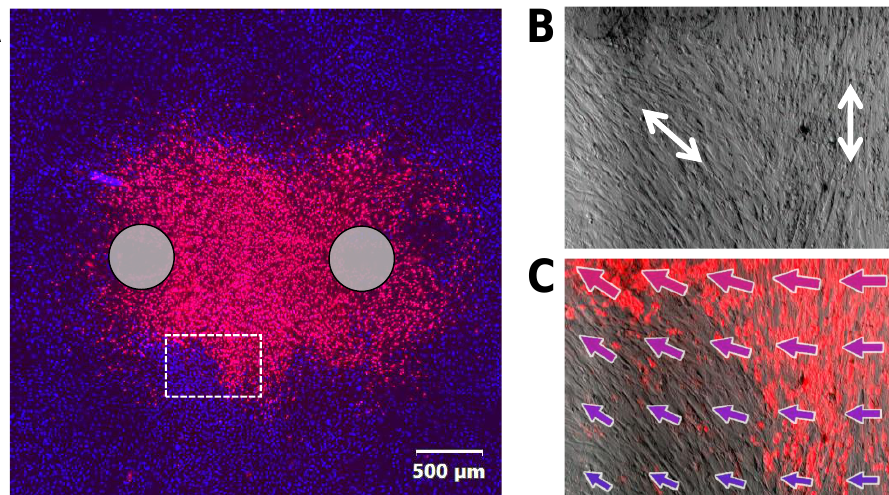
Figure 2. Cell survival depends on orientation in the electric field. ( A ) A non-oval cell death region (red, Pr staining) in a dense monolayer of smooth muscle cells (~100% confluency). Nuclei of live cells are counterstained blue with Hoechst dye. Cells were killed by applying 100 unipolar 600-ns pulses at 2.7 kV, 10 Hz between two electrodes (gray circles). The region outlined by a white rectangle is magnified in ( B , C ). ( B ) shows the bright field image of the monolayer, with the predominant cell orientation marked by white arrows. ( C ) shows the same bright field image overlayed with the Pr staining and electric field vectors. Vector lengths are proportional to the electric field strength. Cells oriented perpendicular to electric field are more likely to die, even at regions of weaker electric field.